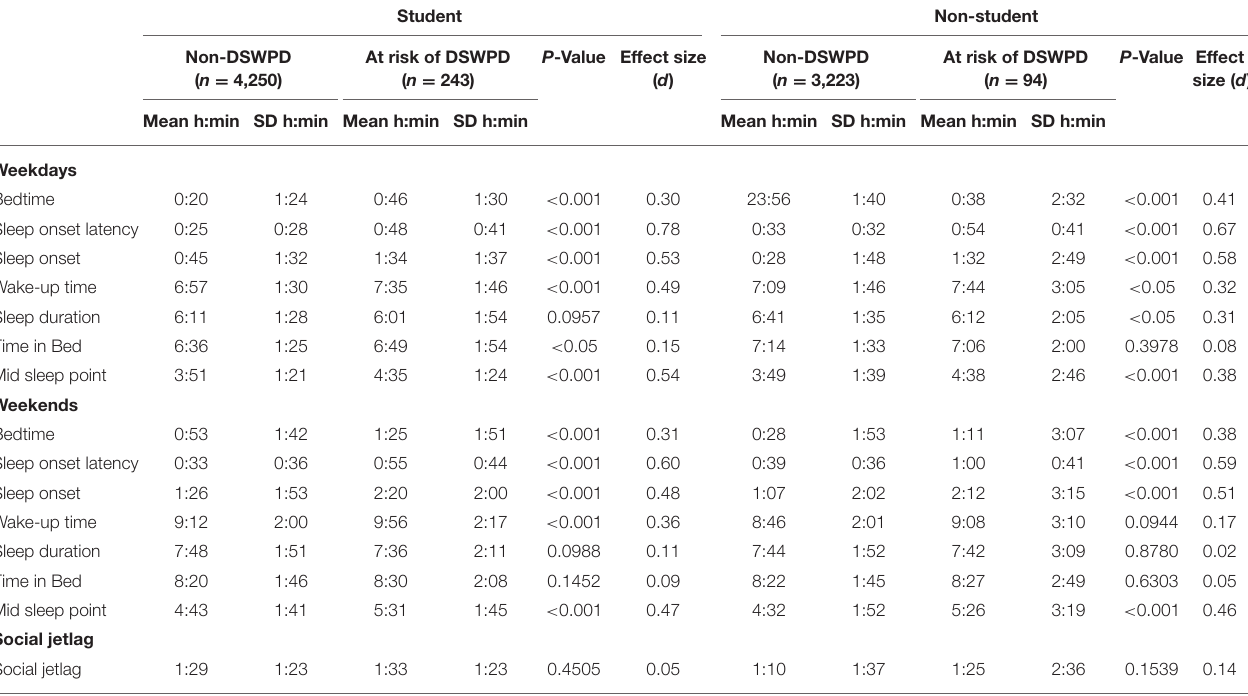
TABLE 3 | Sleep behaviors of the students and non-students at risk of DSWPD and those who were not. Student